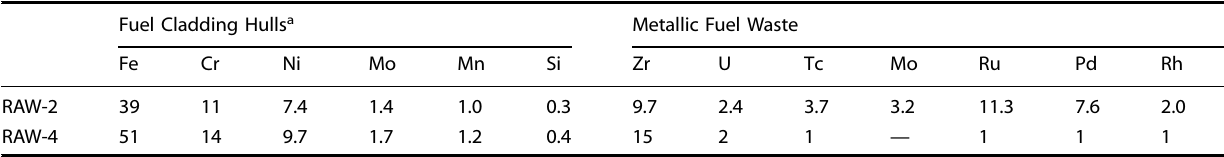
Table 5. Approximate as-batched alloy compositions, in wt%.